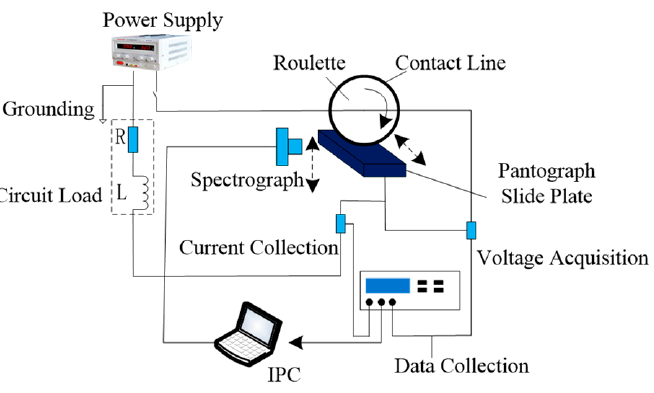
Figure 9. Schematic diagram of the pantograph–catenary arc experiment device.